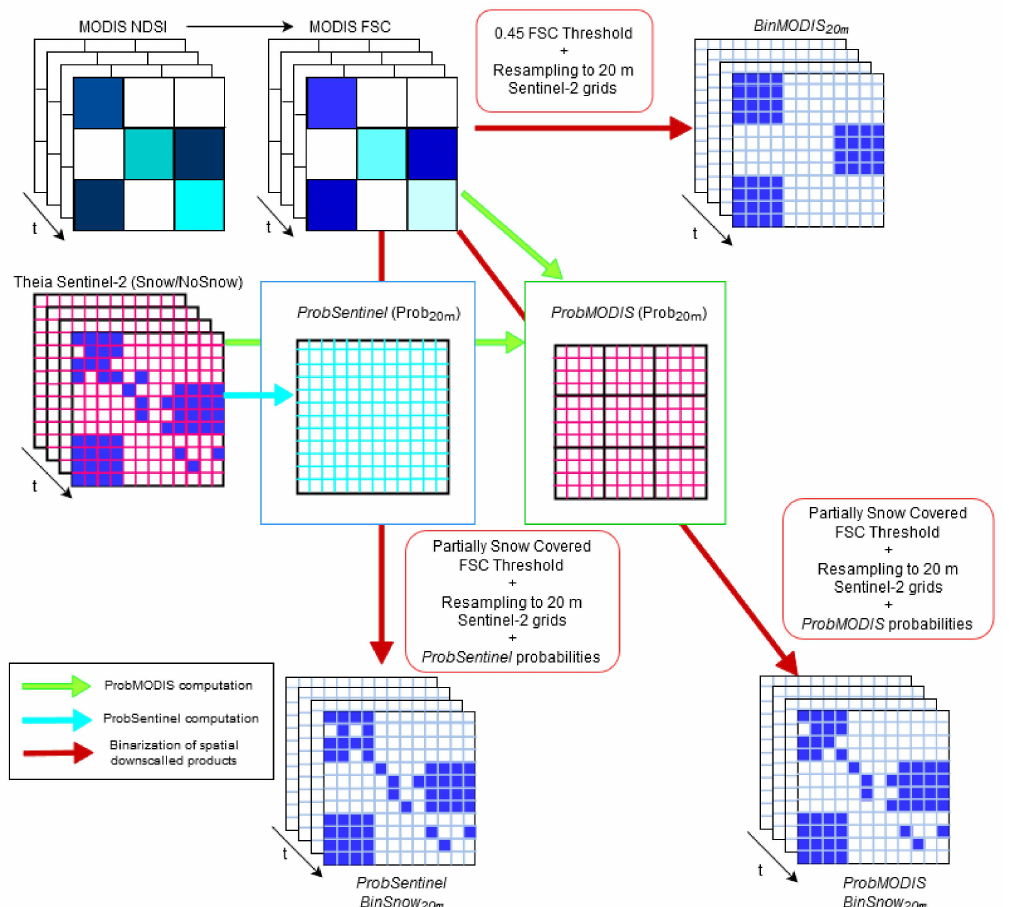
Figure 2. Overall flow chart of the methodology. Blue and green arrows indicate the information needed to derive ProbSentinel and ProbMODIS snow occurrence probabilities. Red arrows depict the observations needed to obtain the spatially downscaled snow distribution